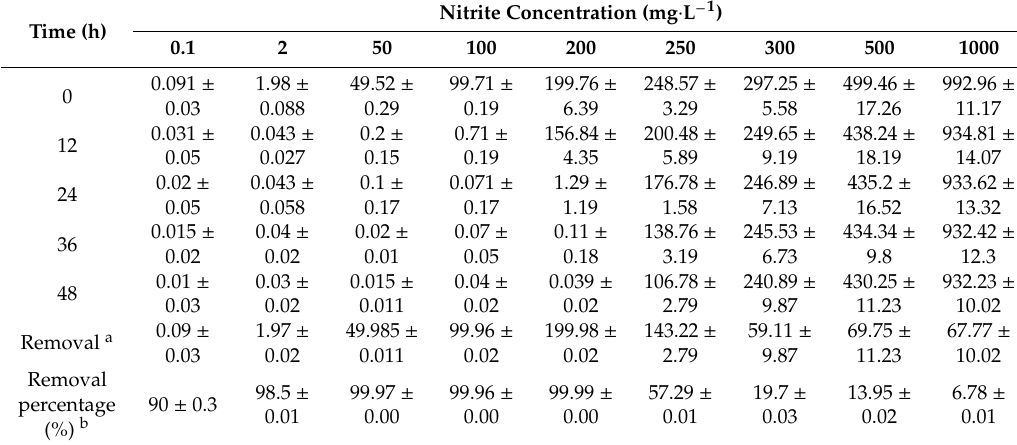
Table 1. The nitrite removal characteristics of Bacillus sp. SC16 under different nitrite concentrations.